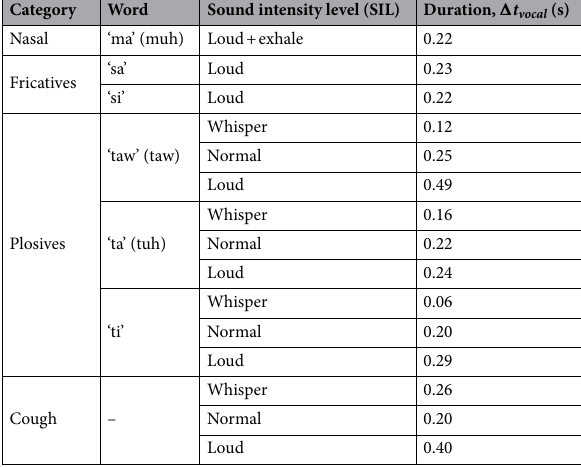
Table 1. Test points. Peak sound intensity levels (SIL): Loud: SIL = 97.5 dB, σ SIL = 4.8 dB, Normal: SIL = 85.9 dB, σ SIL = 2.5 dB, Whisper: SIL = 79.9 dB, σ SIL = 8.9